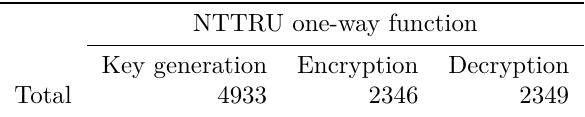
Table 2: Skylake cycle counts of our AVX2 optimized constant-time implementation of the NTRU one-way function over the ring Z 7681 [ X ] / ( X 768 − X 384 + 1). The counts are the medians of 256 executions each.